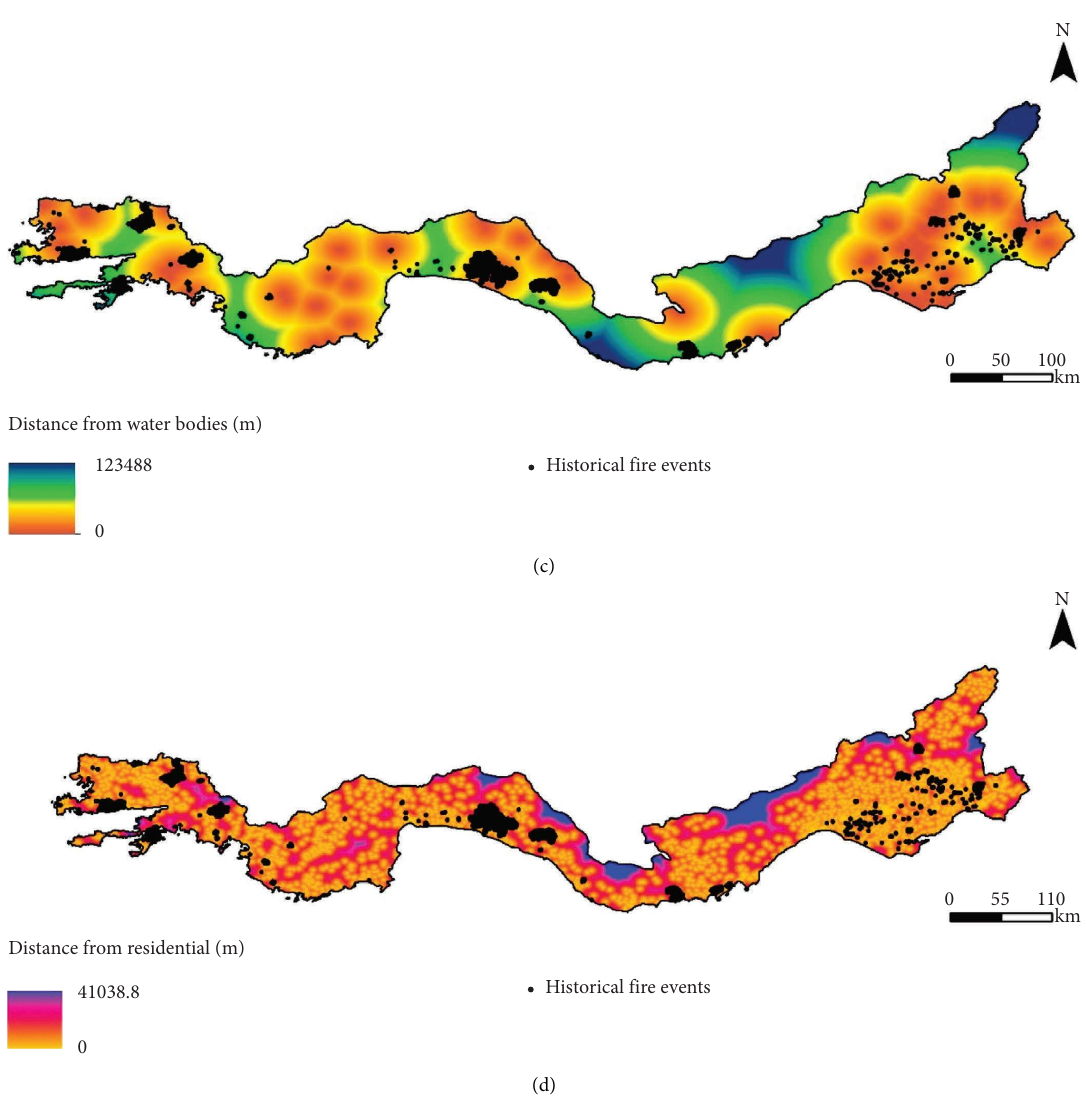
Figure 4: Forest fre conditioning factors: (a) relative humidity, (b) wind speed, (c) distance from water bodies, and (d) distance from